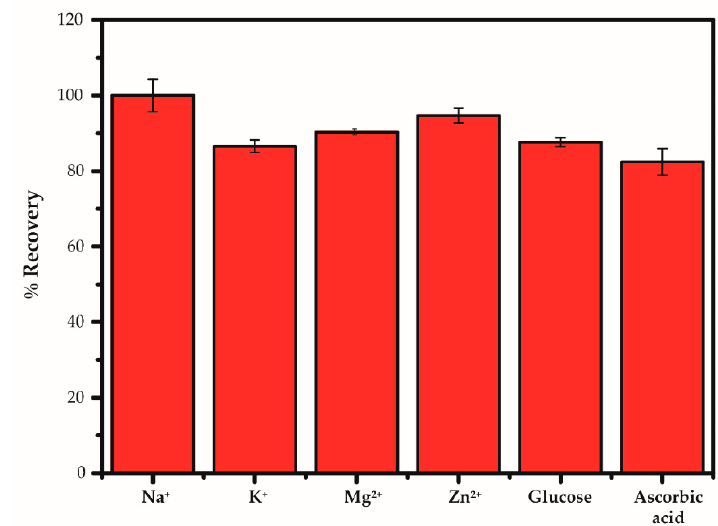
Figure 8. Comparisons of interfering substances added into 50 mM sodium under the optimized conditions of measurement by using the AgNPs/GO/SPE sensors based on chronoamperometry. conditions of measurement by using the AgNPs / GO / SPE sensors based on